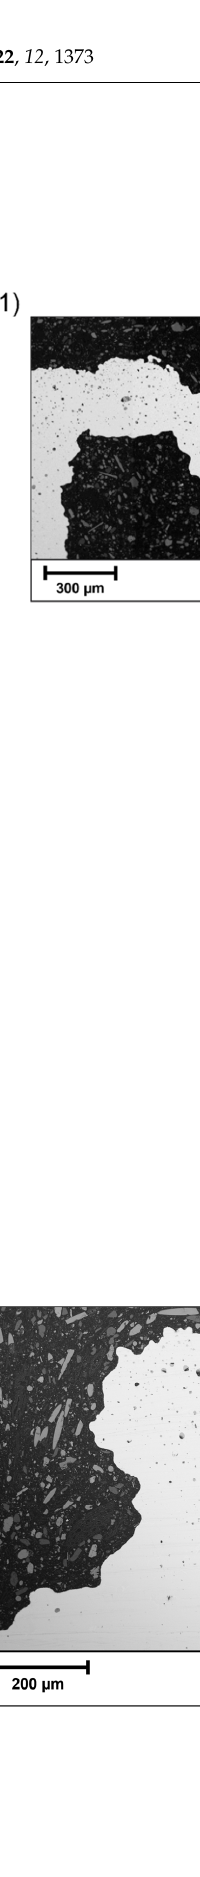
12 of 21 Figure 9. The SEM (JEOL JSM-6610LV) images of DLC coatings deposited on Voronoi structure with magnification ( A ) ×90, ( B ) ×200, and ( C ) ×1000.